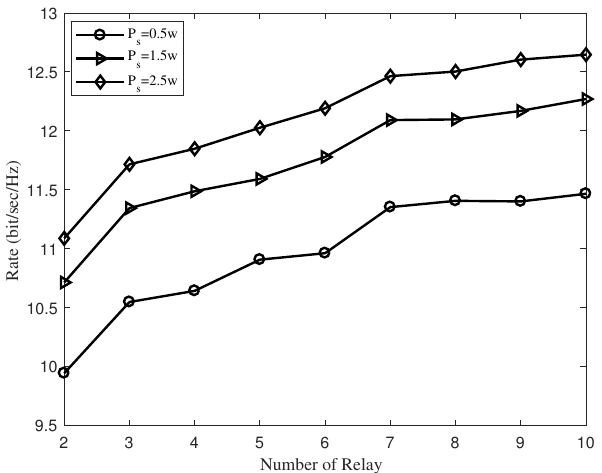
Figure 5. The transmission rate versus the number of relays with different source transmit power P s